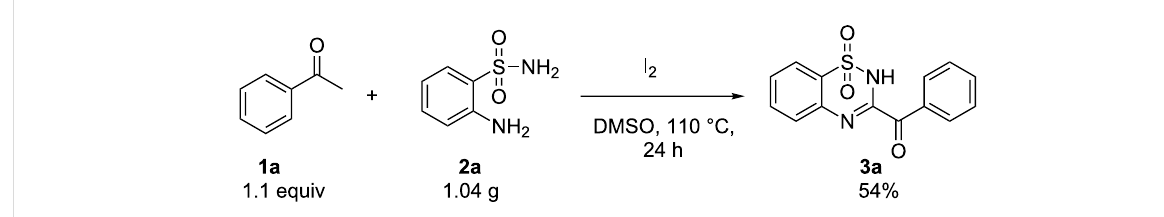
Scheme 5: Gram scale reaction between 1a and 2a .